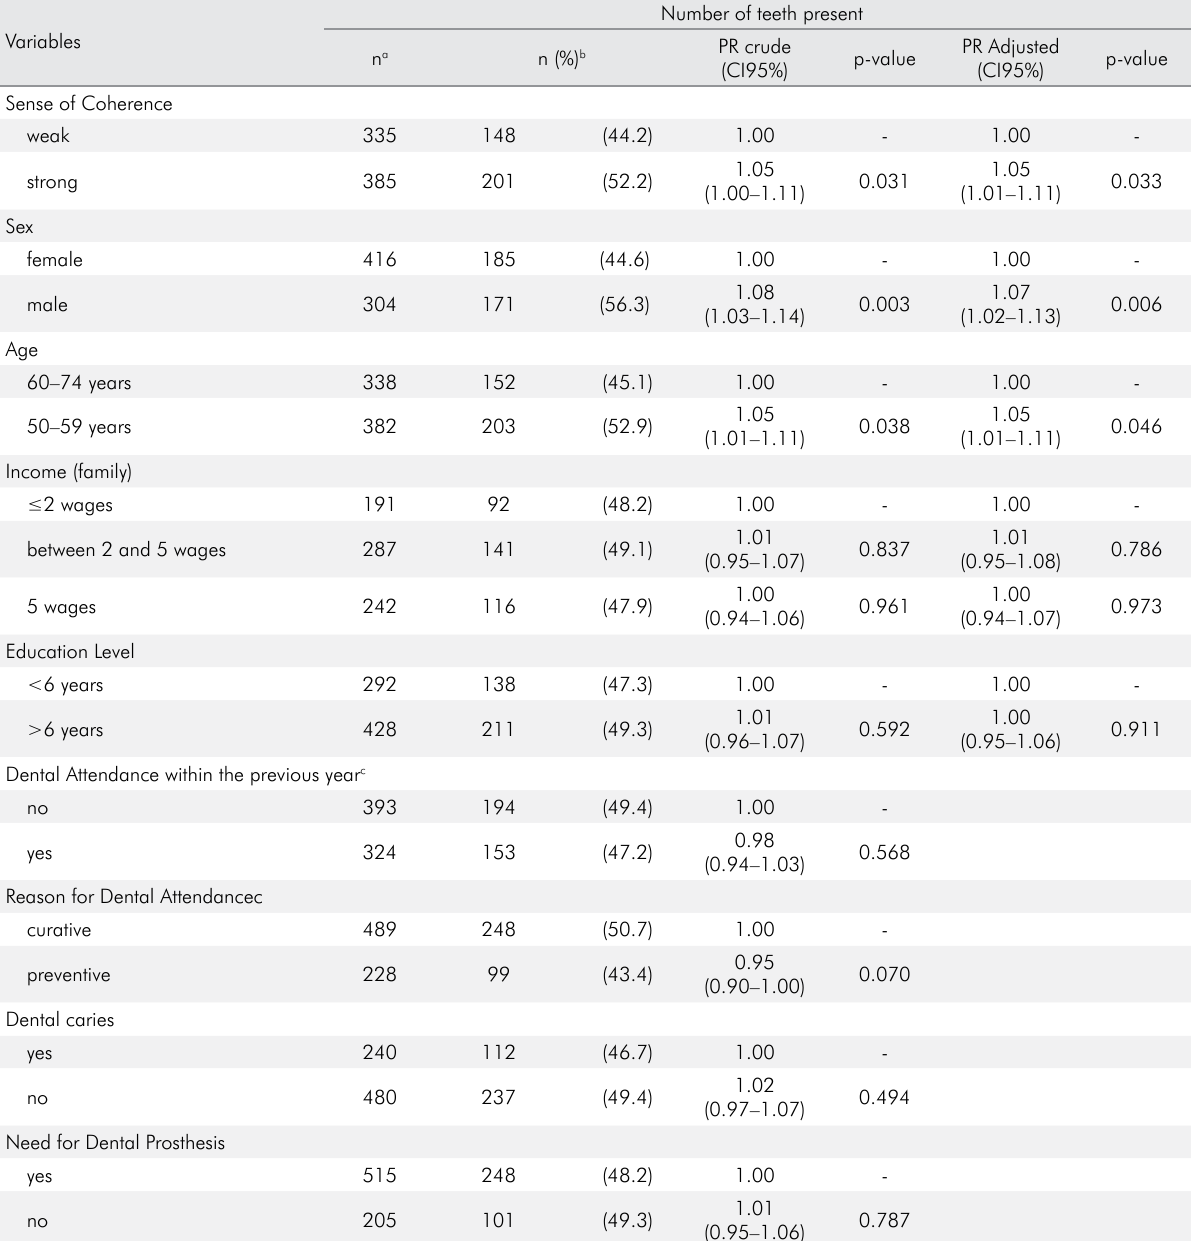
Table 3. Results of the crude and adjusted Poisson regression with outcome number of teeth present (n = 720).